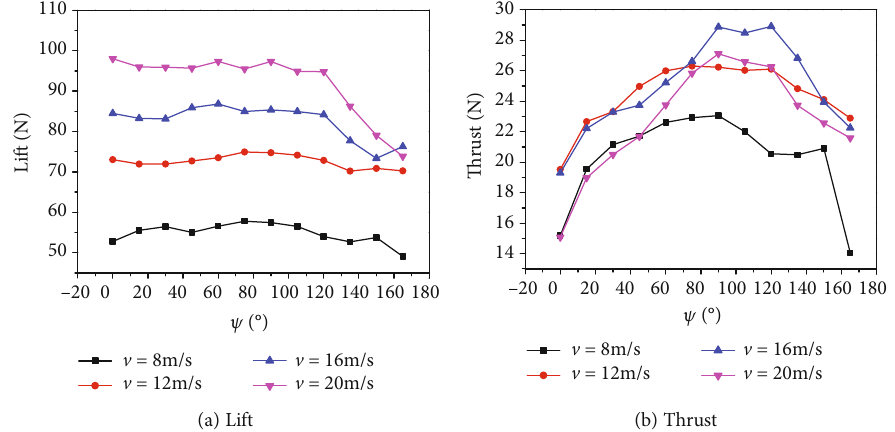
Figure 12: The variation curve of the installation angle of the double leading edge winglet with the fl ow ( α = 0 °